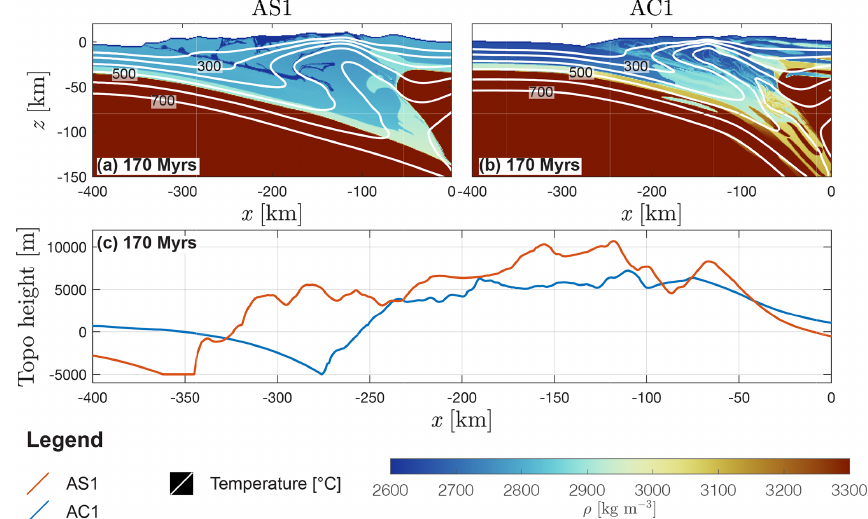
Figure 9. Wedge geometry at 170Myr in model history. Blue to red is the density field calculated by the algorithm for (a) AS1 (LEOS) and (b) AC1 (CD model). White lines are several isotherms. (c) Topographic elevation of AS1 (red line) and AC1 (blue